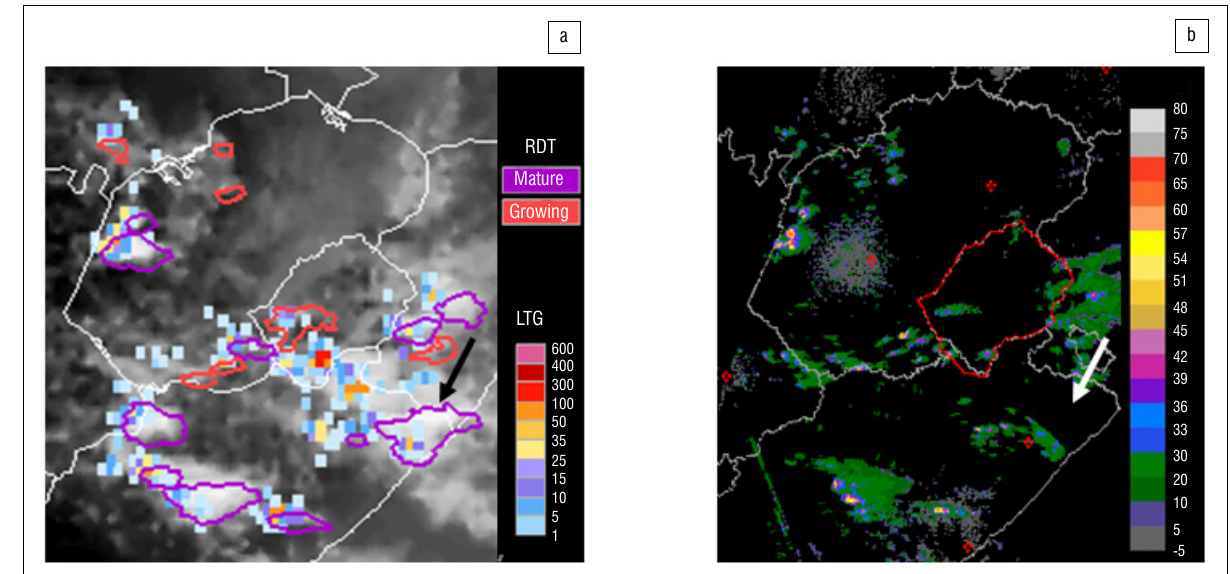
Figure 5: (a) RDT data at 11:30 UTC and lightning from 11:20 to 11:40 UTC and (b) radar reflectivity at 11:30 UTC on 9 November 2012 over the southeastern parts of South